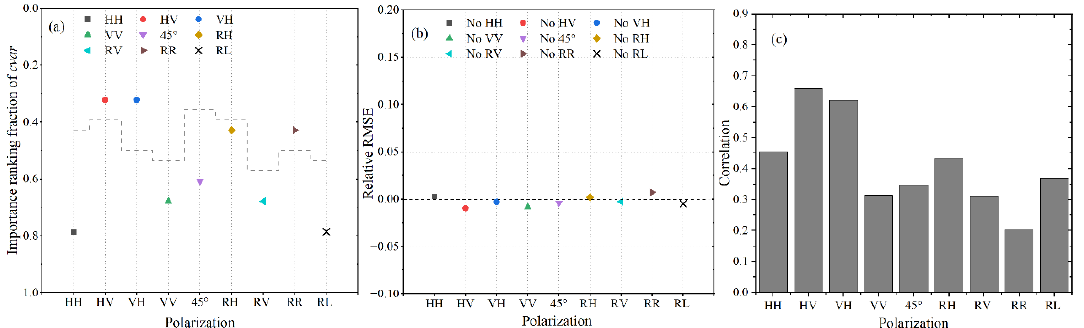
Figure 14. The importance of cvar to SWH retrieval from single-polarization models. ( a ) The importance ranking of cvar provided by XGBoost models normalized to 0 – 1. The dotted line represents the optimal feature sets under different polarizations. ( b ) The effect of removing cvar on the SWH estimation from different polarized models. Different markers in various colors represent cvar of different polarizations. ( c ) The correlation between cvar and ERA5 SWH under different polarizations.